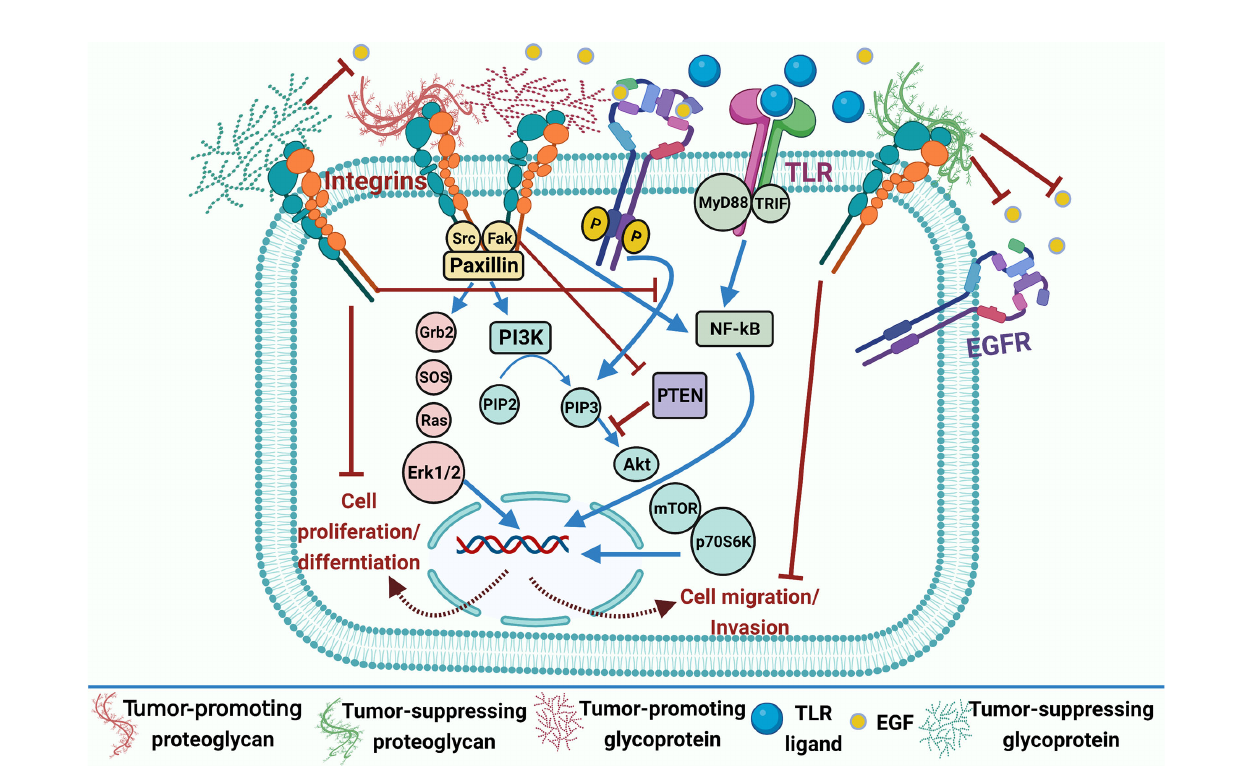
FIGURE 3 | Dual effect of ECM glycoproteins and proteoglycans in lung cancer. Tumor-promoting glycoproteins (e.g., laminin 5 and fi bronectin); laminin expression enhances phospho-EGFR or phospho-Akt expression and loss of PTEN; fi bronectin activates toll-like receptors (TLRs) to promote NF- k B activation as well as EGFR- dependent Akt/mTOR/p70S6K signaling pathway; and thus, it stimulates cell proliferation and differentiation in lung cancer. Tumor-promoting proteoglycans (e.g., GPC5) prompted cell migration and metastasis. Tumor-suppressing glycoproteins (e.g., fi bulins1,3, and 5) compete with EGF and inhibit EGFR activation. Tumor- suppressing proteoglycans (e.g., GPC3 and SDC ‐ 1) can regulate EGF and many intracellular signaling pathways inhibiting cell invasion and migration. Blue arrows for stimulation; dashed red arrows for cellular effect; and red “ T ” sign for